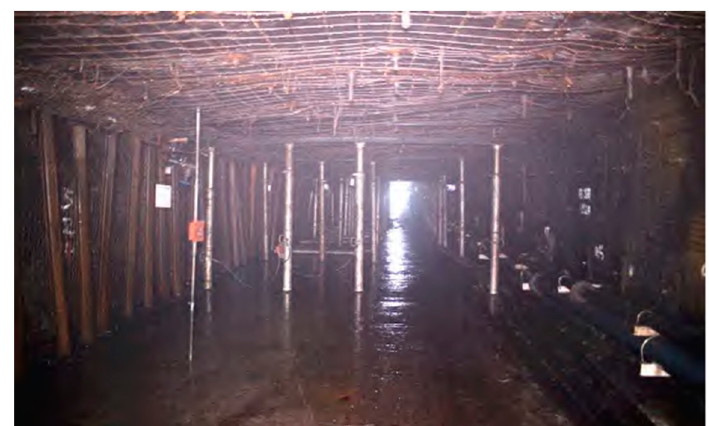
Figure 22. Real-time monitoring curve of the abscission layer in the immediate roof.